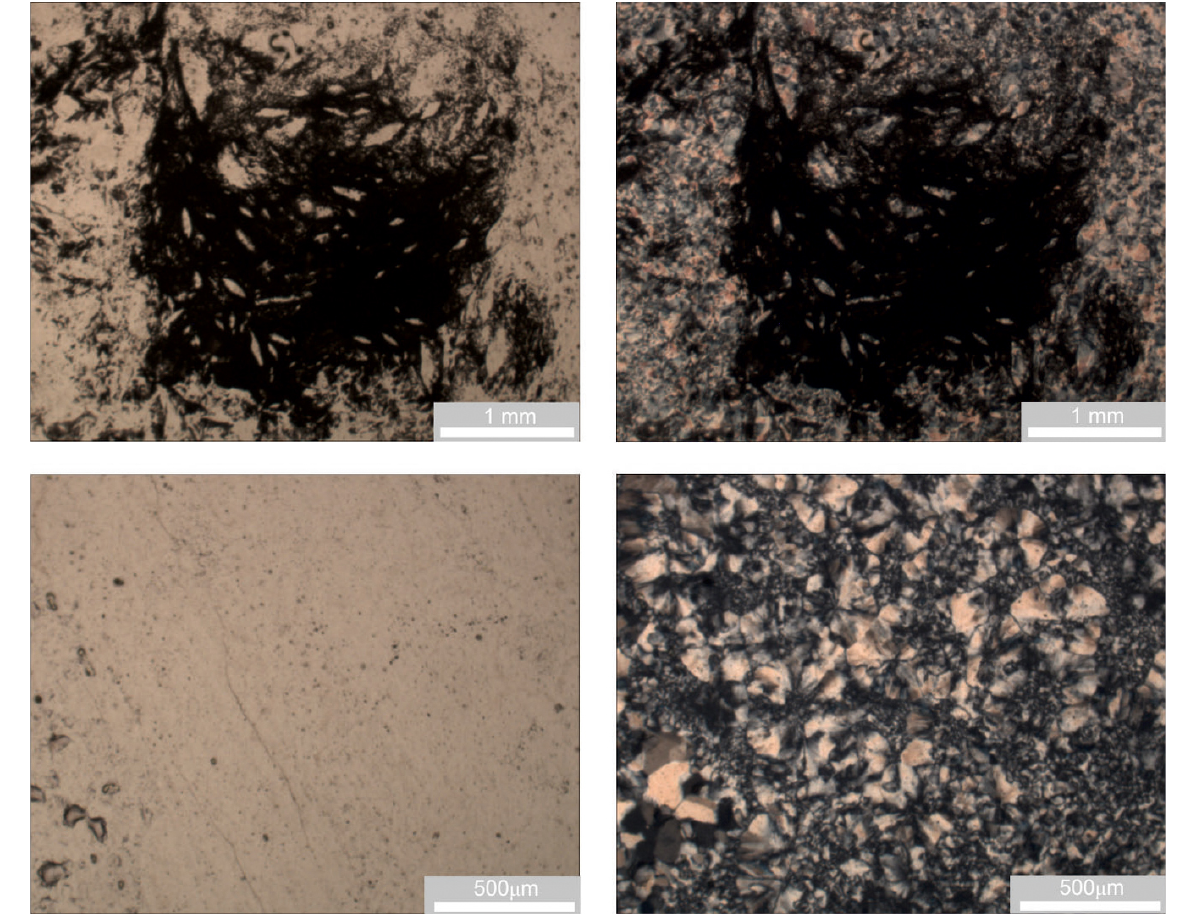
Figure 8. Thin section of Morera1 chert. Images with normal polariser (left) and crossed polariser (right). Detail of a dissolution cavity filled with clay minerals, gypsiferous pseudomorphs, and fibrous and microcrystalline